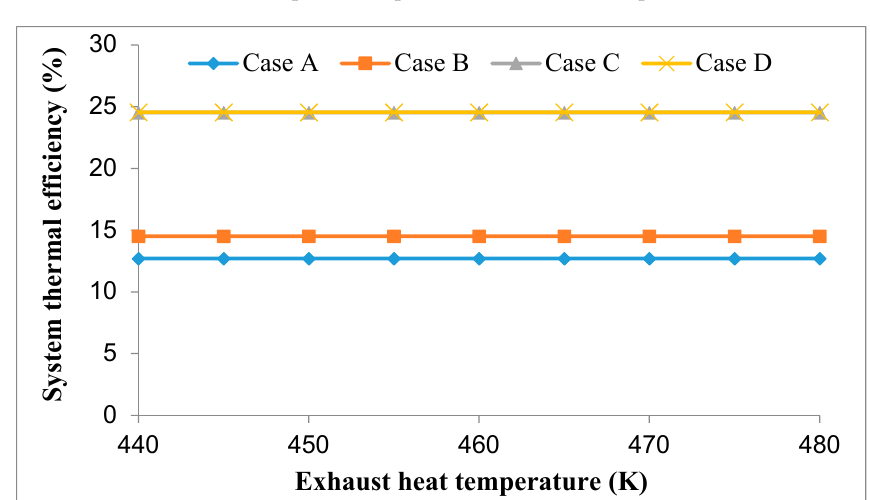
Figure 9. Net power output vs. exhaust heat temperature.